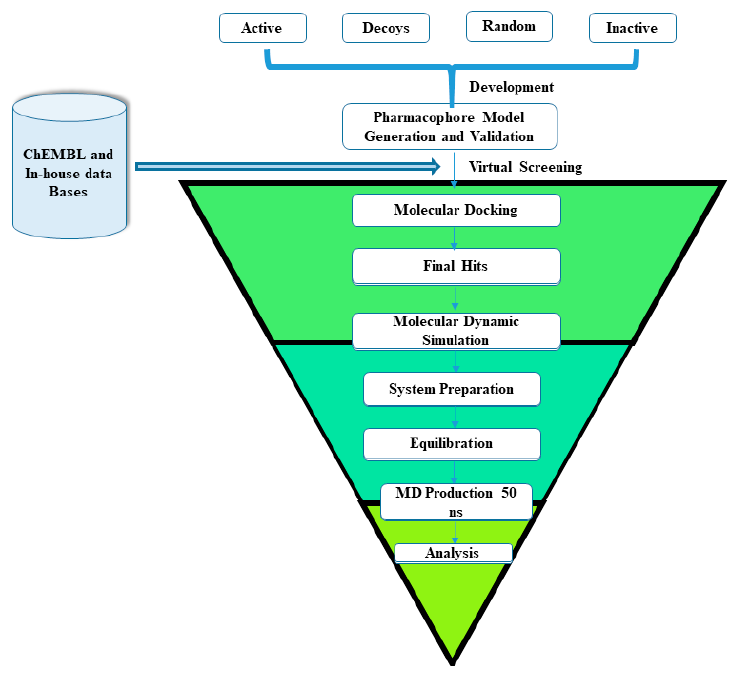
Scheme 1. Schematic representation of ligand-based virtual screening and Molecular Dynamic simulation.